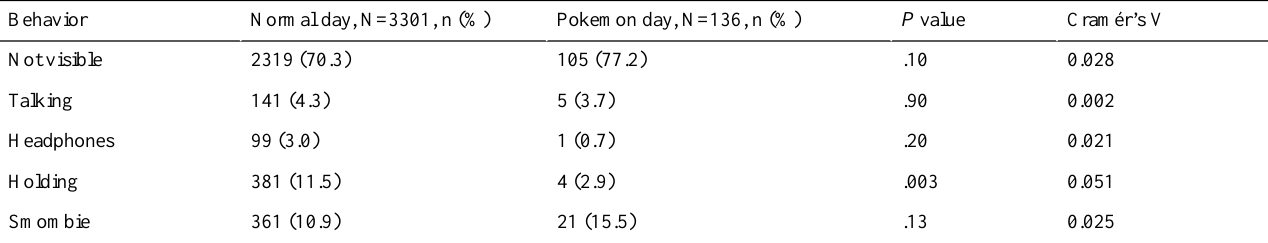
Table 10. Influence of the Pokemon Go Community Day on the smartphone usage behavior (globally P =.006, V=0.065).